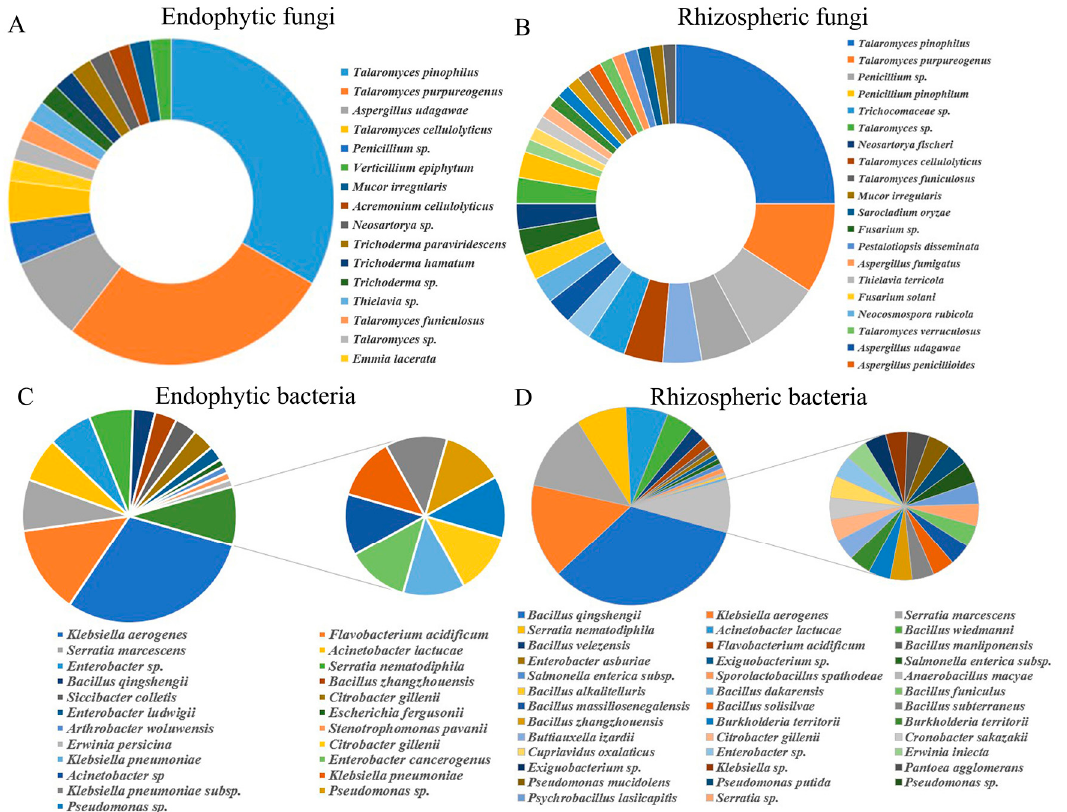
Figure 1. Taxonomic affiliations based on partial 16S rRNA and internal transcribed spacer (ITS) gene sequencing analysis: The relative abundance of cultivable bacteria and fungi inhabiting upland rhizosphere and endophyte. ( A ) Fungi isolated from endophyte, ( B ) Fungi isolated from rhizosphere, ( C ) Bacteria isolated from endophyte, ( D ) Bacteria isolated from rhizosphere.